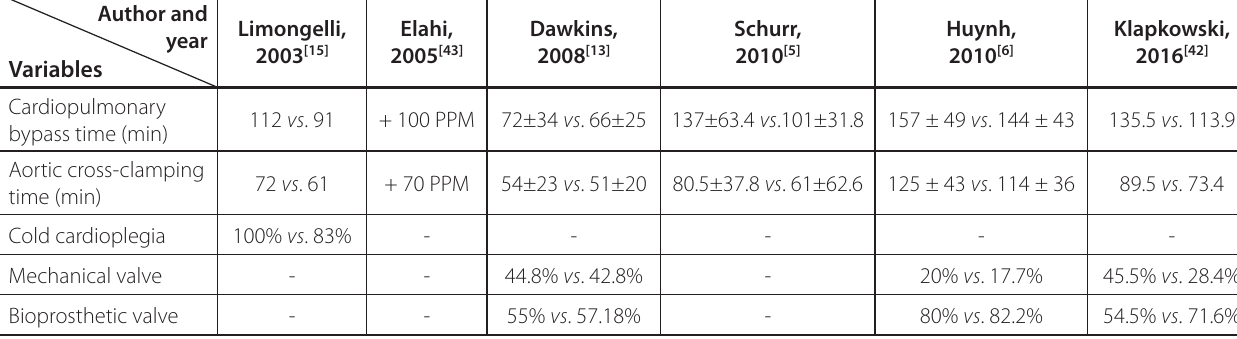
Table 4 . List of intraoperative variables; PPM vs .